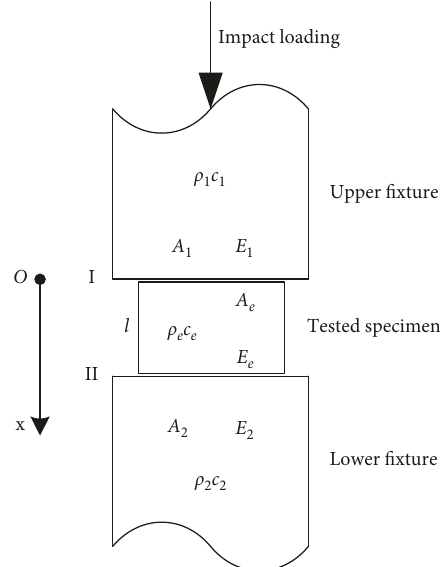
Figure 6: Simplified connection